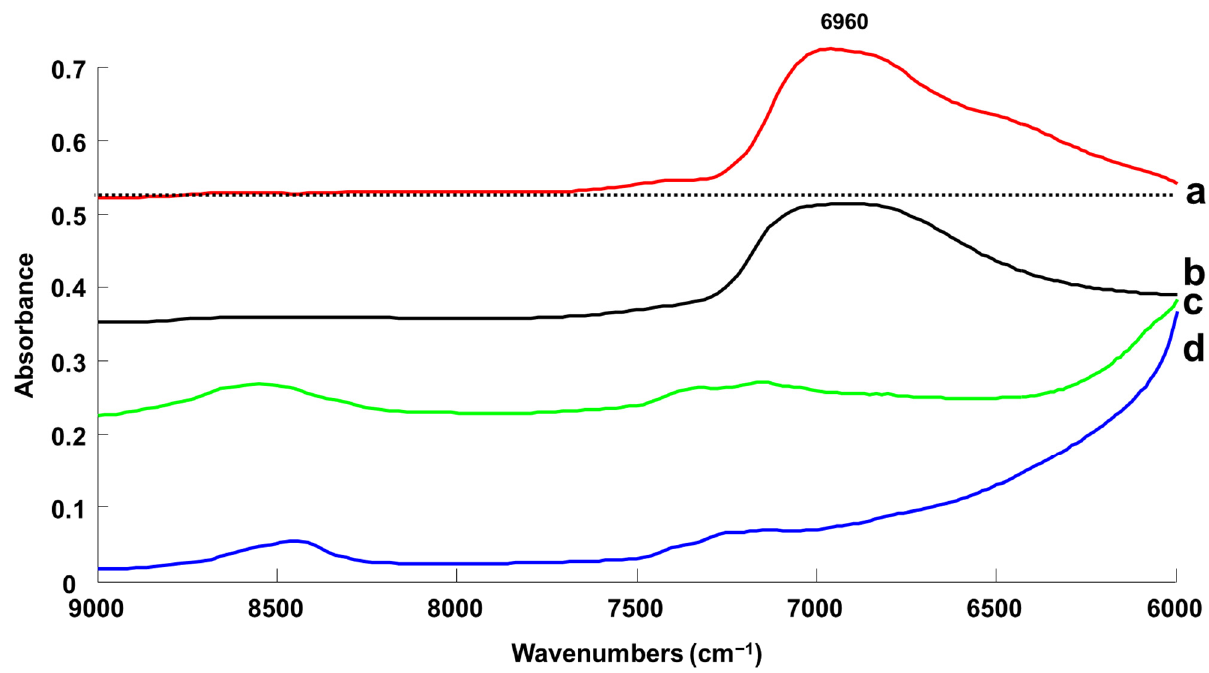
Figure 7. First regression coefficient of PLSR of NIR-H (dotted line indicates the zero baseline) ( a ), water spectrum ( b ), L-Proline ( c ) and Levulinic Acid ( d ). Spectra have been offset for clarity.